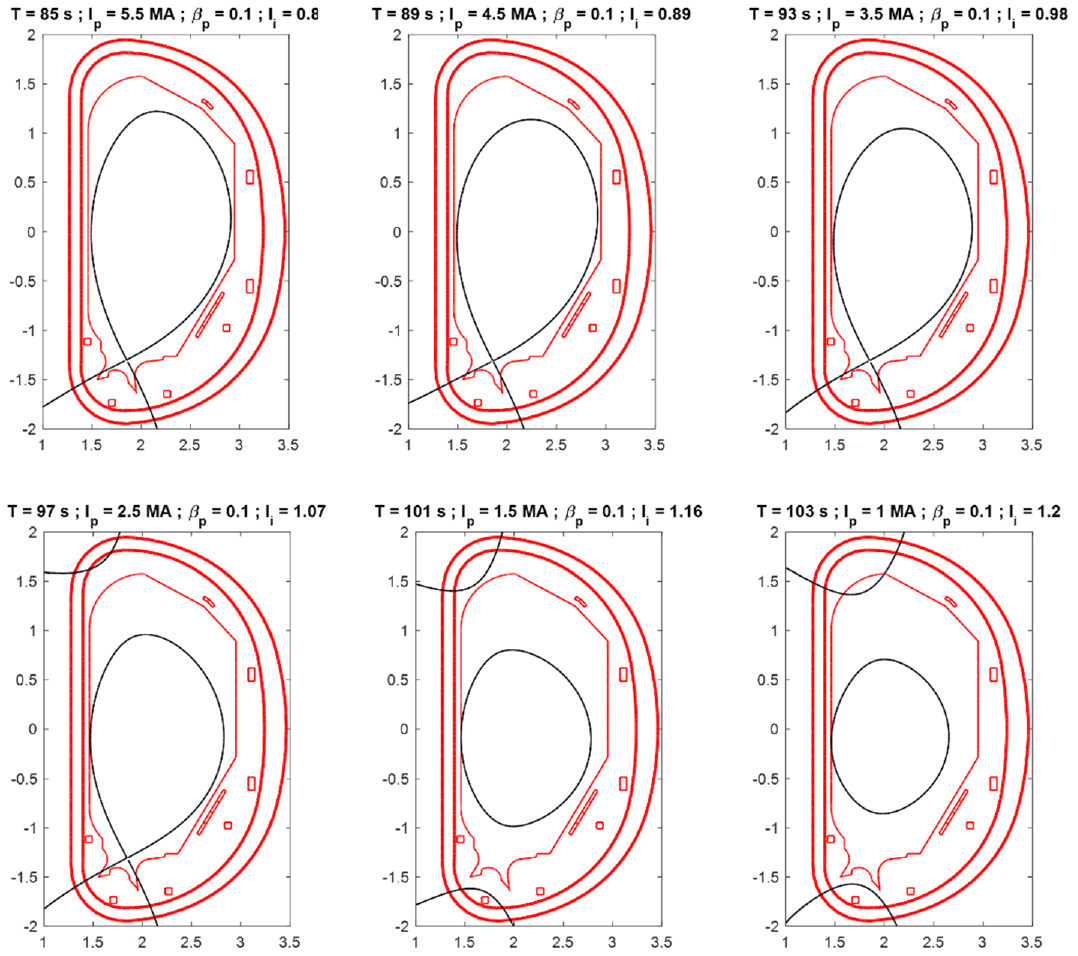
Figure 8. Time evolution of plasma shapes of the ramp-down phase with a plasma current rate equal to 250 kA/s.